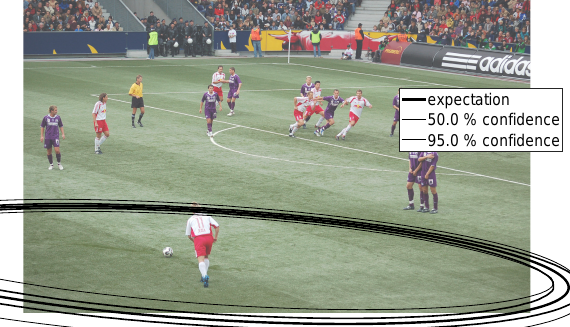
Figure 7. Confidence regions for the locus of the ellipse boun- ded by quartic plane curves. The precision of the locus increa- ses with diminishing distance to the used tie points.